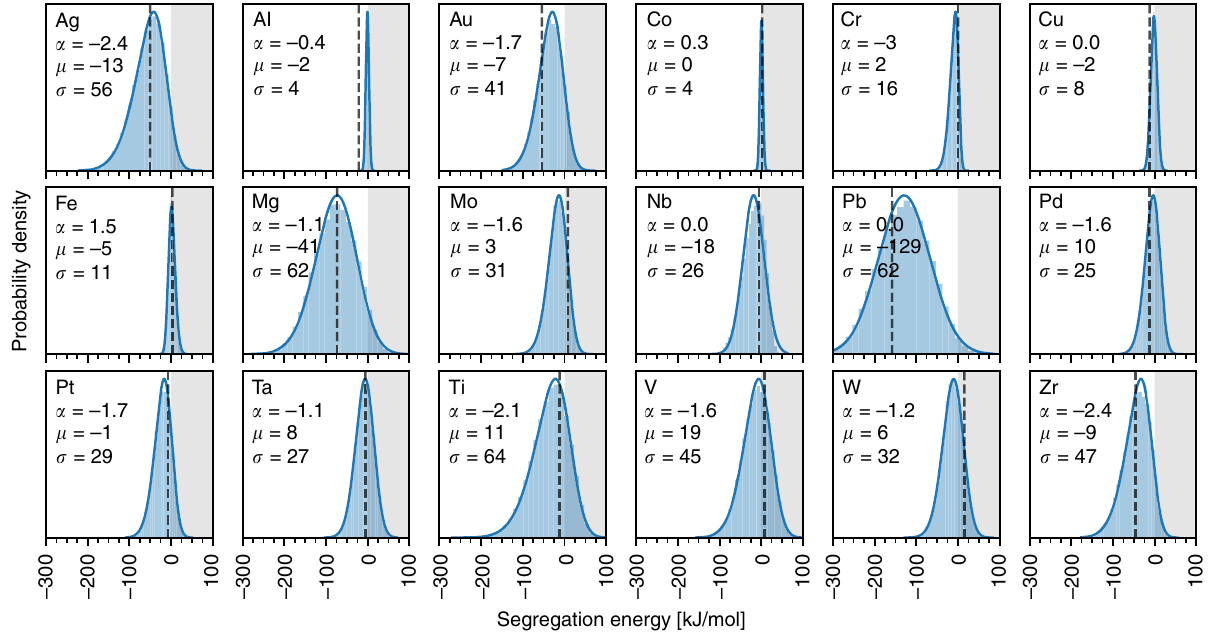
Fig. 4 GB segregation spectra in Ni-based alloys. Using the accelerated ML model outlined in Fig. 3, we compute GB segregation energy spectra for 18 solutes 37,40,42,53,58,75 – 81 in a 20x20x20 nm 3 Ni polycrystal of grain size 10 nm; the anti-segregation region ( Δ E seg i > 0) is shaded. The spectra are fi tted to the skew-normal function Eq. (3) (solid line), and the value of the characteristic energy μ (kJ/mol), width σ (kJ/mol), and shape α of the function are listed. Also, the spectra are compared to the “ average ” segregation energy (dashed vertical line) used to charecterize these alloys in the database of Murdoch and Schuh 55